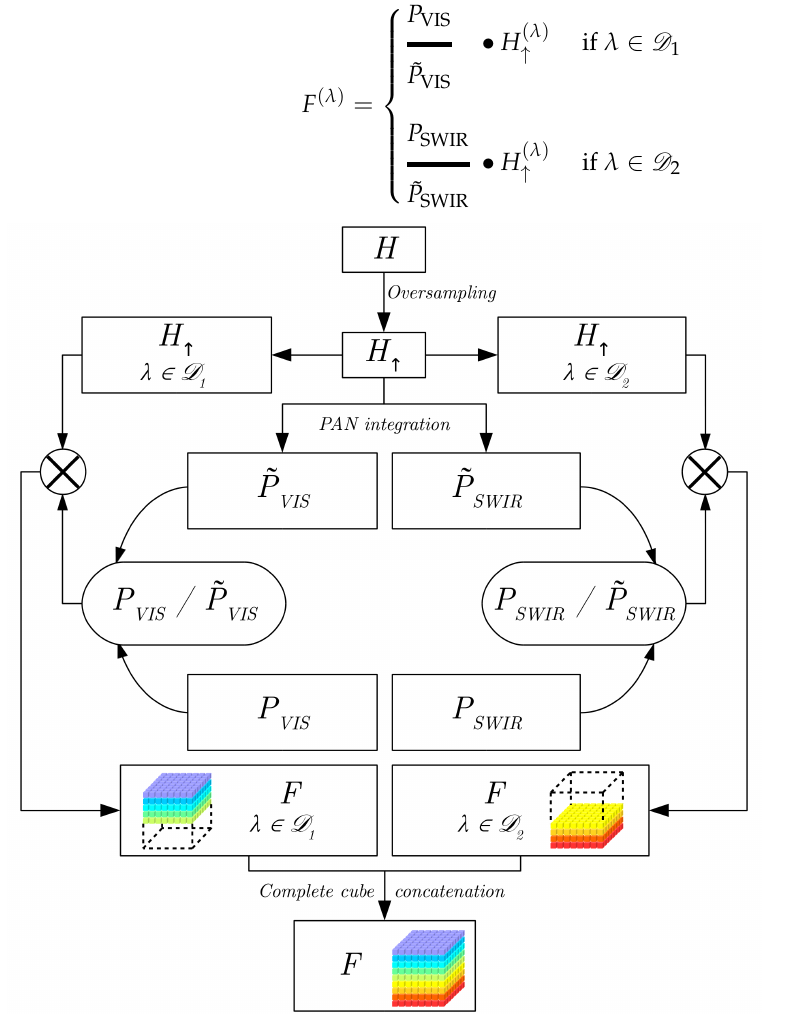
Figure 1. Gain-2P method